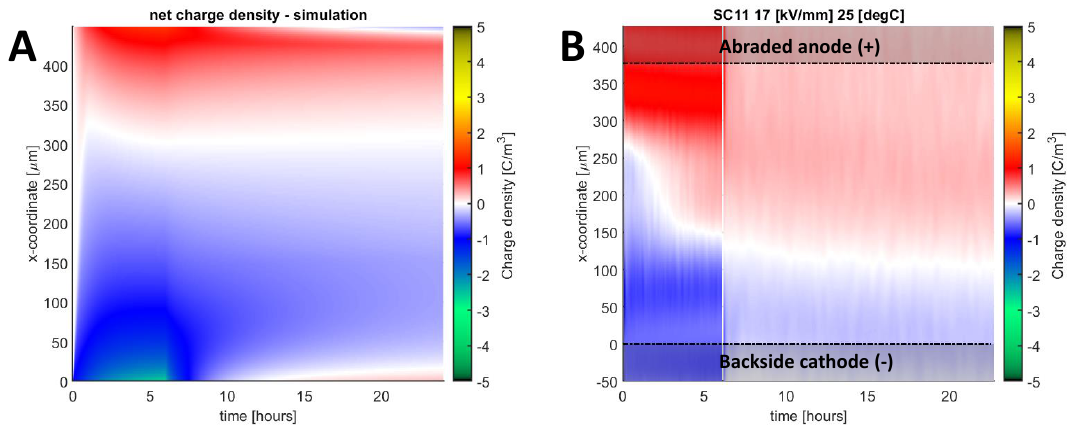
Figure 13. Colormap of net charge density in simulation ( A ) and measurement ( B ) for sample SC-11, subjected to + 7.5 kV polarization at 25 °C.